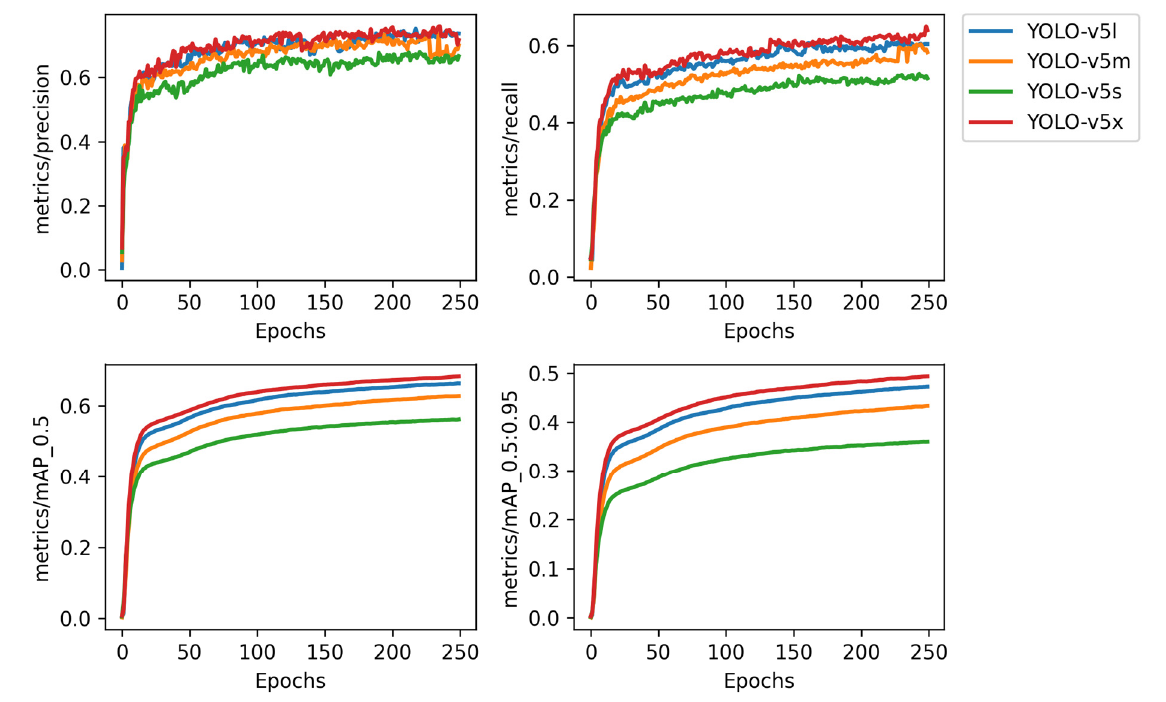
Figure 10. Evaluation performance of the proposed VPP framework based on various deep learning YOLO structures (i.e., YOLOv5s, YOLOv5m, or YOLOv5l) in terms of precision, recall, and mAP.